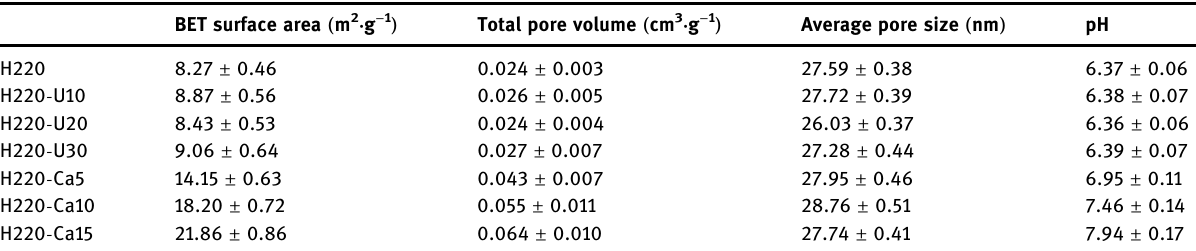
Table 1: Surface area, pore information, and pH of hydrochar after HTC under di ff erent conditions BET surface area ( m 2 · g − 1